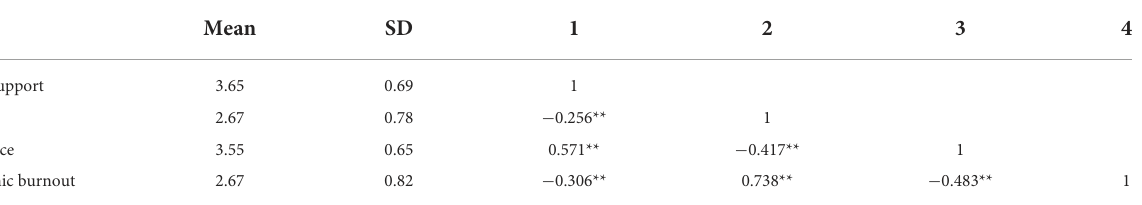
TABLE 5 Result of the correlative